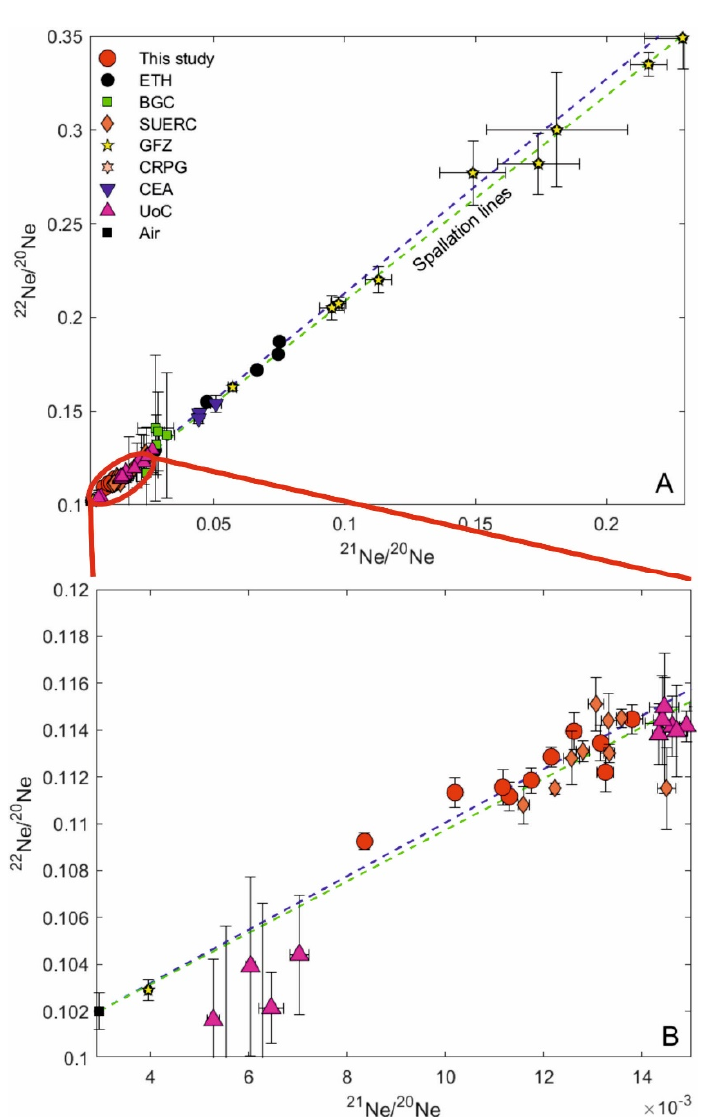
Figure 6. Neon isotope composition of 19.9 mg CREU-1 quartz using the ARGUS VI mass spectrometer. Data were plotted on or close to established cosmogenic spallation lines ( A ) ([26] blue and [27] green), with small deviations that were similar to earlier determinations ( B ). Data were produced over 4 months. Air value (black square) from [6,22]. Other data are from [5,24,25]. ETH (Switzerland), BGC (USA), SUERC (UK), GFZ (Germany), CRPG (France), CEA: China Earthquake Administration (PR China), UoC: University of Cologne (Germany).